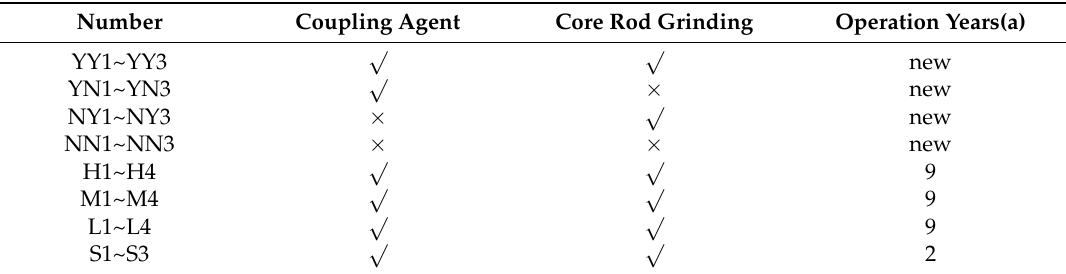
Table 2. Sample information.